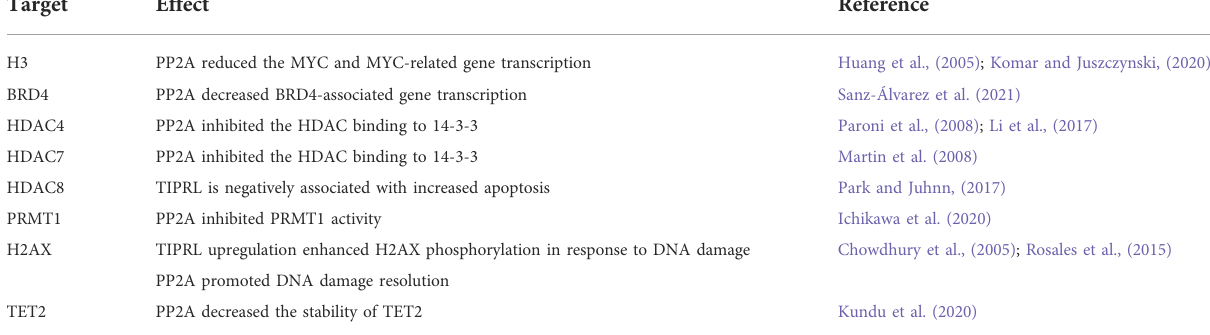
TABLE 1 Epigenetic targets of TIPRL/PP2A